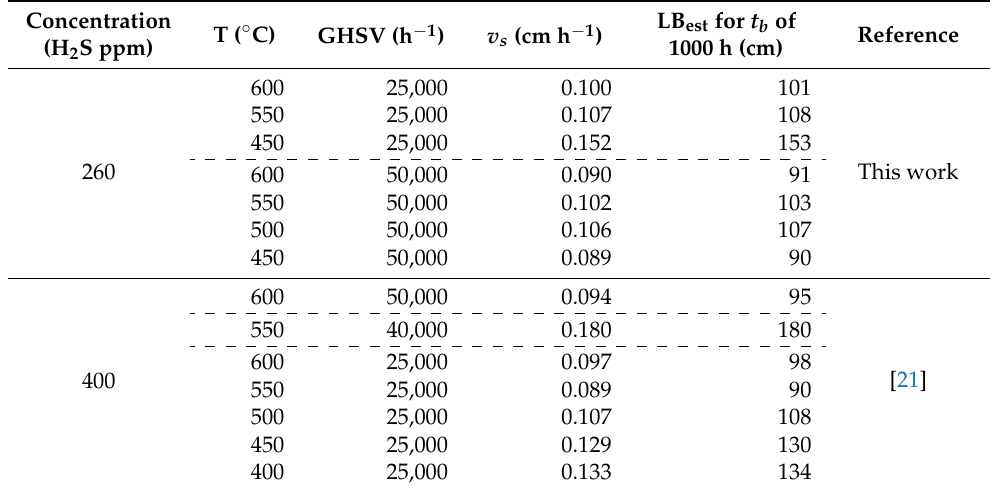
Table 6. Estimation of the BL for a breakthrough time of 1000 h by analyzing the operative conditions and outcomes obtained in our current investigation and those found in the literature [21].